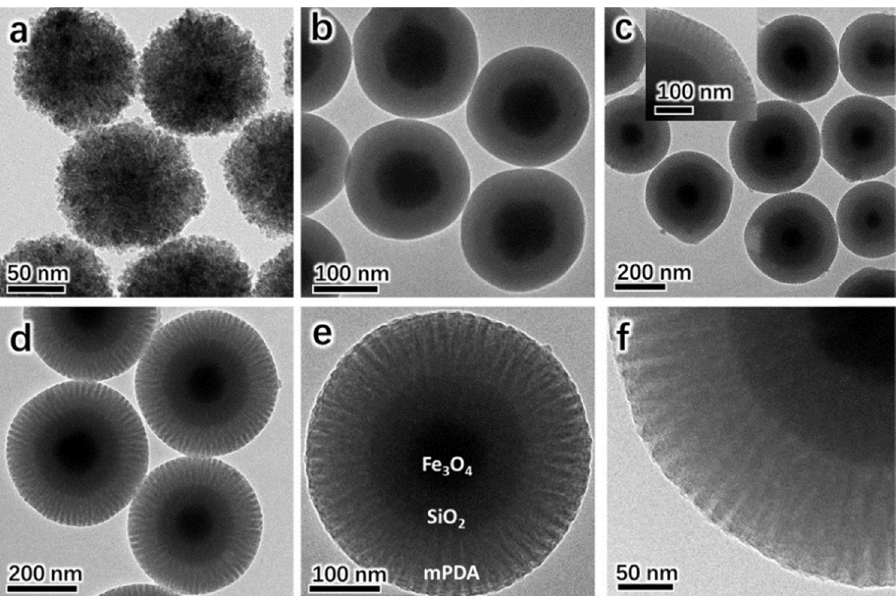
Figure 8: TEM micrograph of core – shell composite: ( a ) synthesis of hydrophilic magnetite particles, ( b ) ferric tetroxide @ n SiO 2 core – shell microspheres, ( c ) Fe 3 O 4 @ n SiO 2 @polydopamine ( PDA ) and dopamine interface co - assembled, self - oxidized composite microspheres, ( d – f ) extraction of acetone from the composite microspheres, core – shell magnetic mesoporous PDA microspheres [ 68 ] ; Copyright: 2020 with permission from